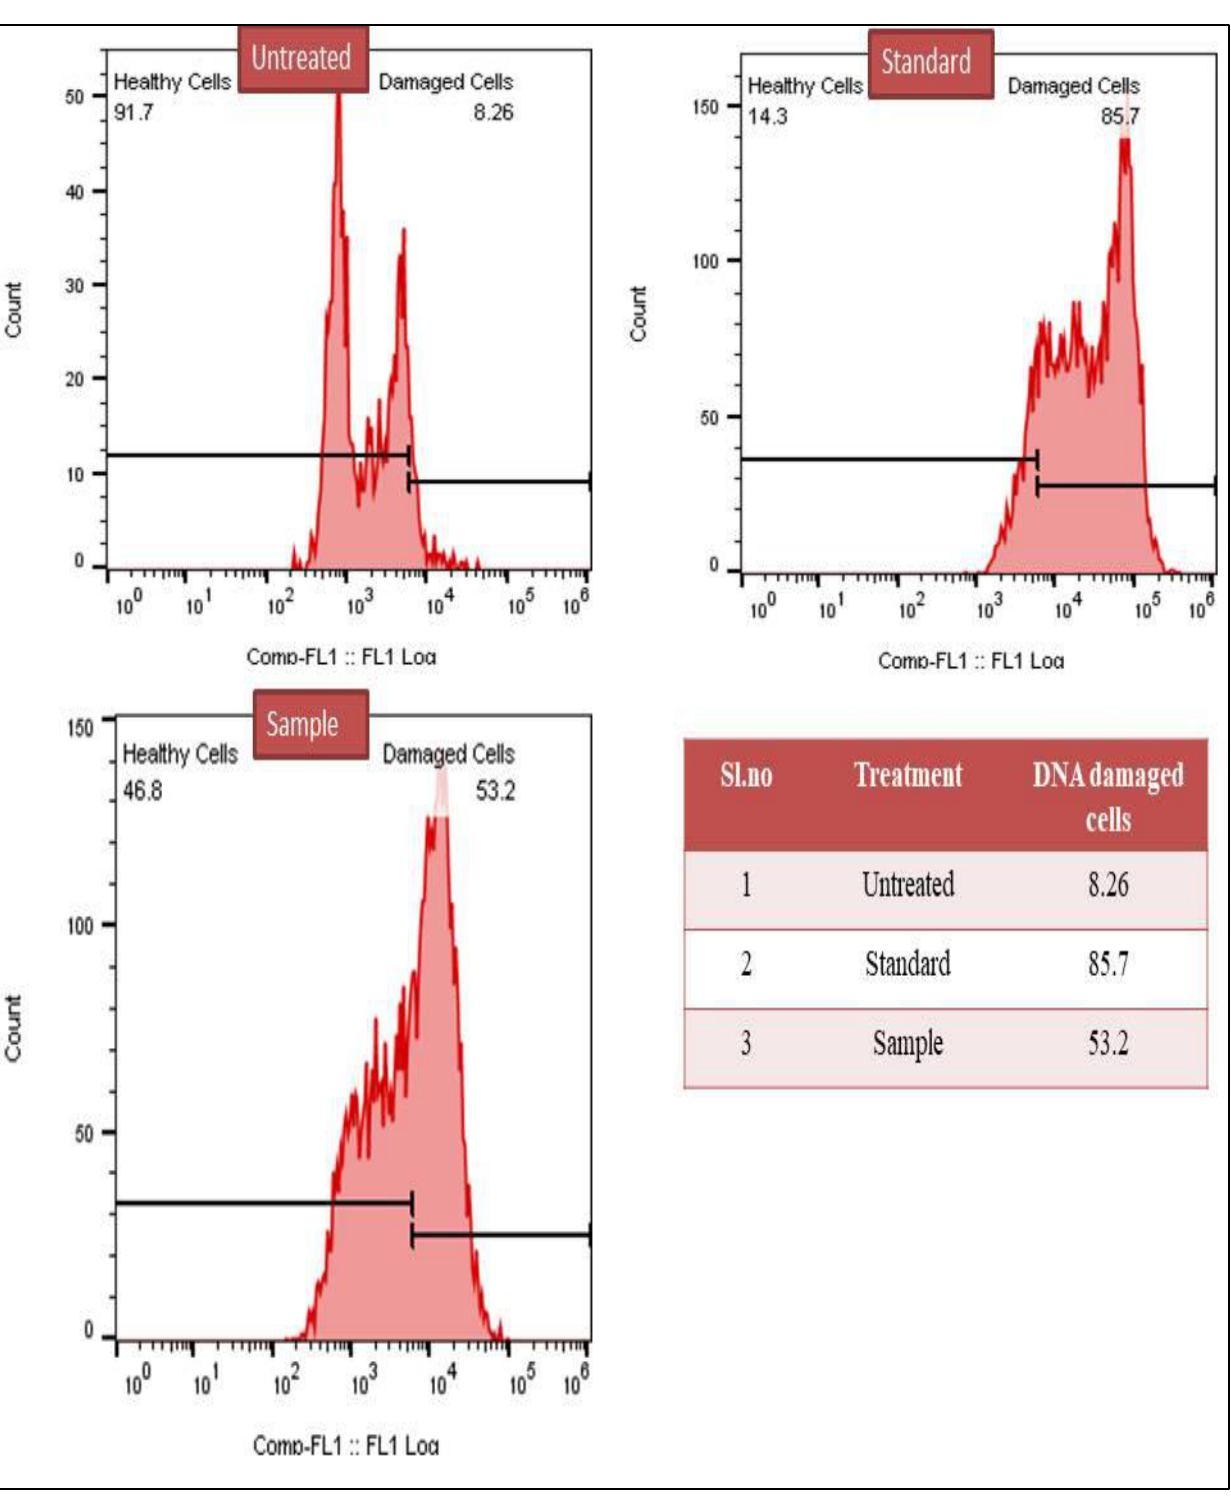
Figure 8. Flow cytometry-based study of DNA damage induced by methanol extract of C. colocynthis in breast cancer MCF-7 cell line.